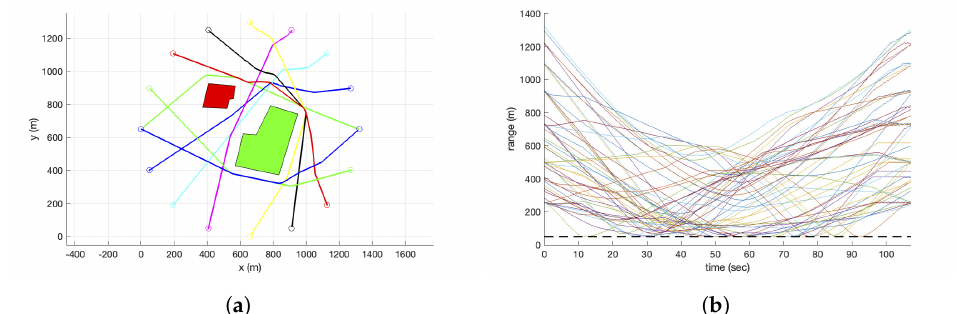
Figure 8. Collision avoidance with 9 UAVs. ( a ) Trajectories. ( b ) Distance to each